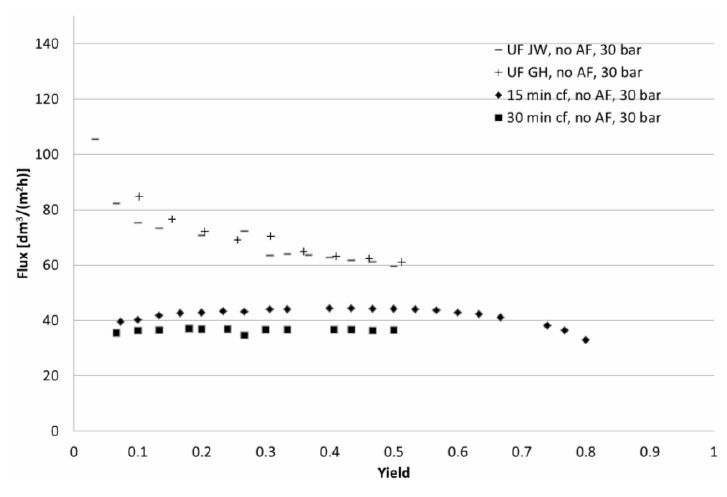
Figure 7. Measured fluxes of nanofiltration at 20 bar, at 40°C.